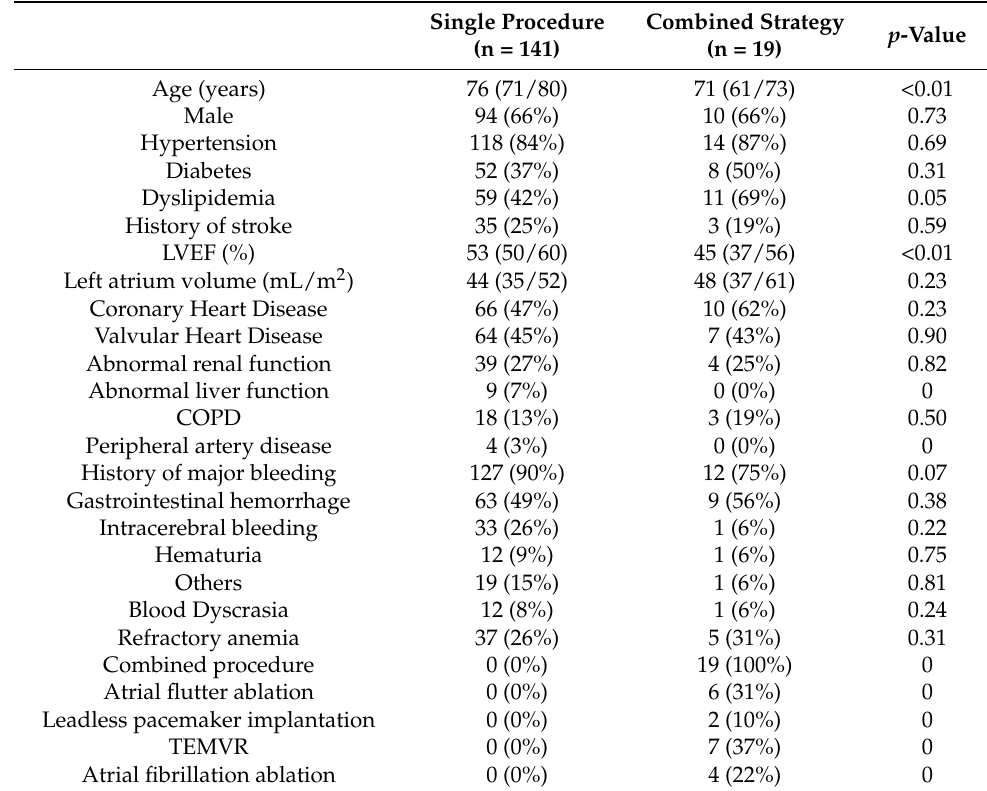
Table 1. Baseline characteristics.